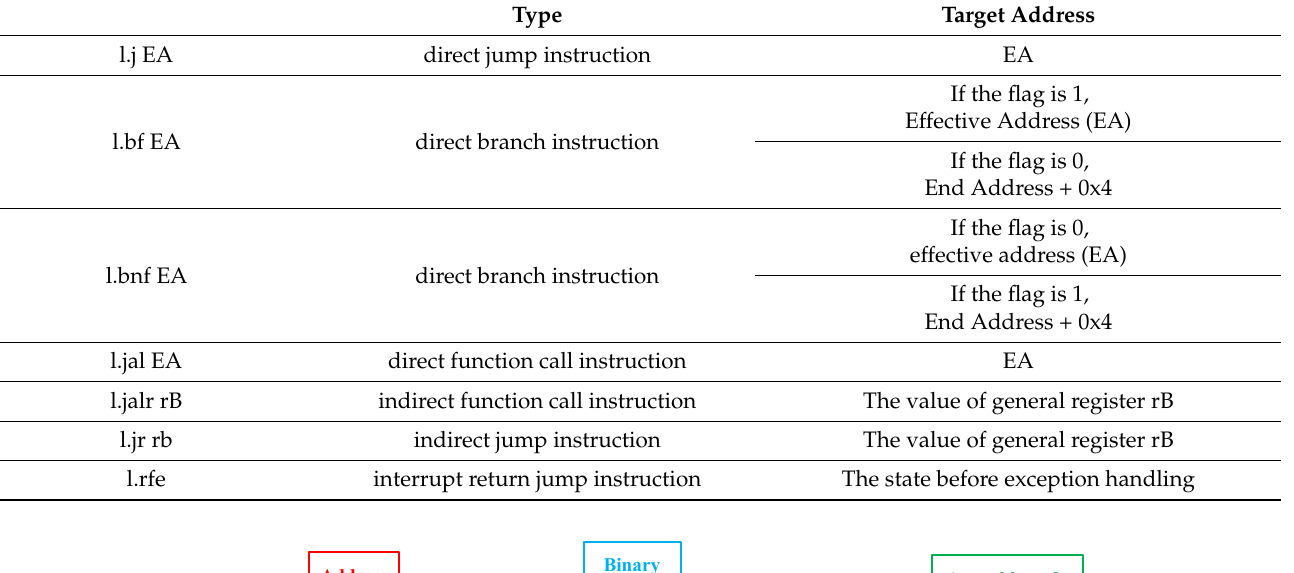
Table 1. Jump instruction types of OR1200 ISA.